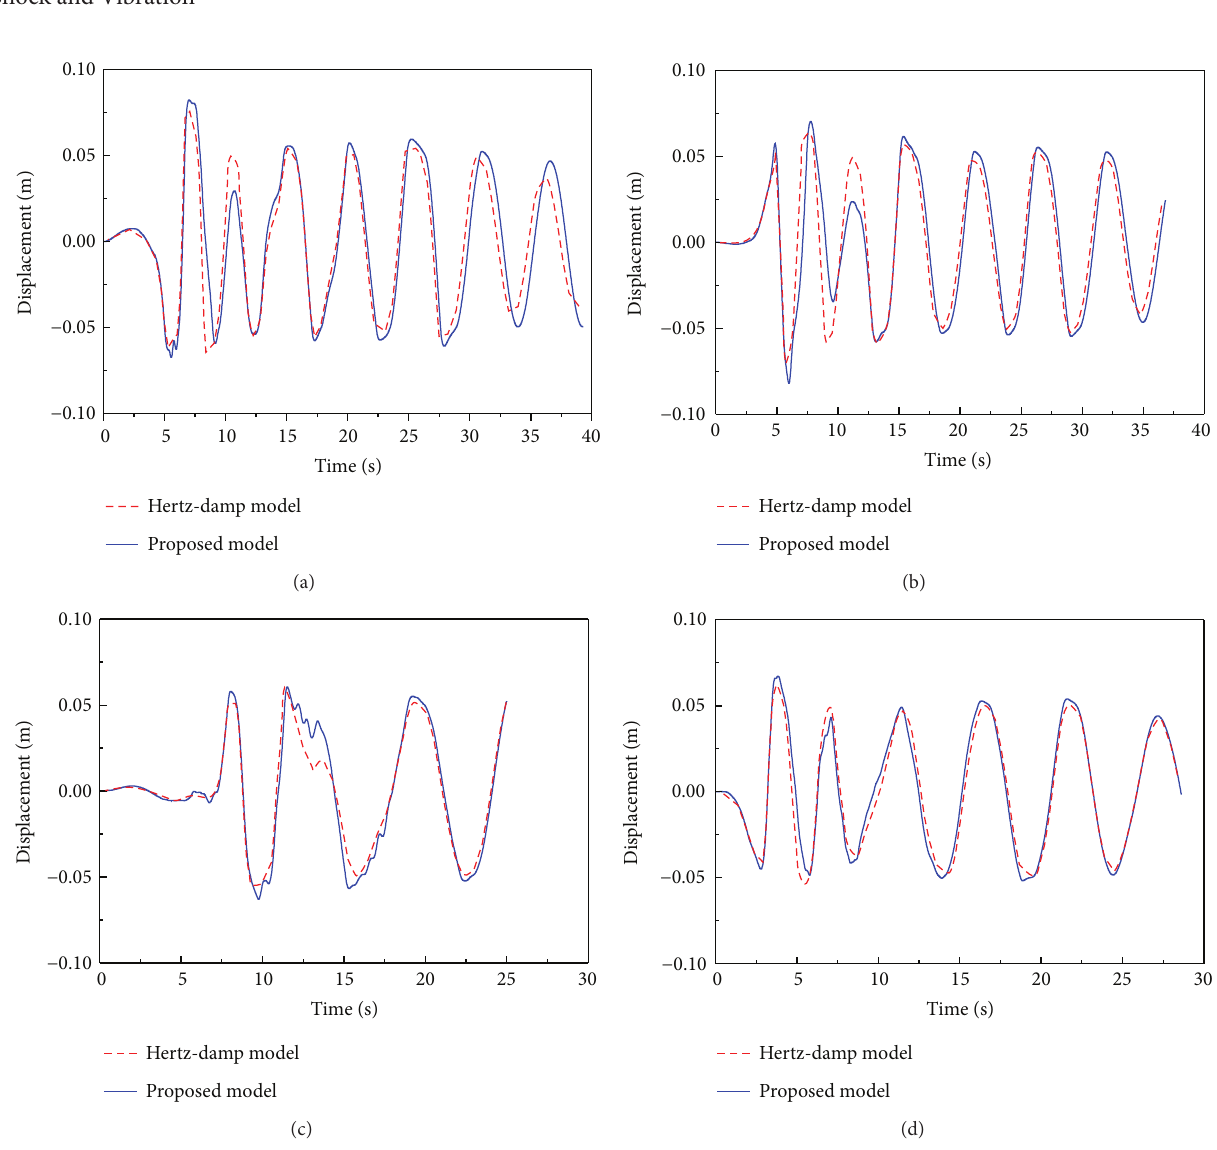
Figure 8: Displacement time history of isolated structure (a) N1; (b) N2; (c) N3; (d)